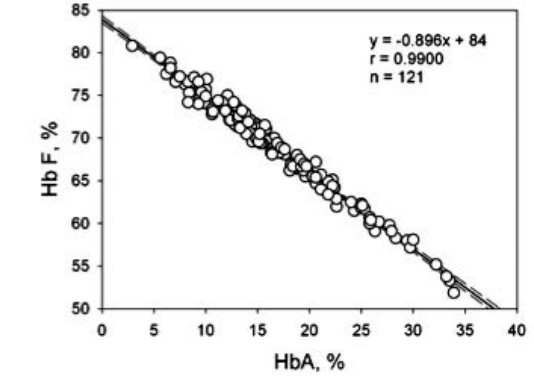
Figure 1. Typical high-performance liquid chromatography pro- file obtained from the analysis of a blood sample from a new- born.